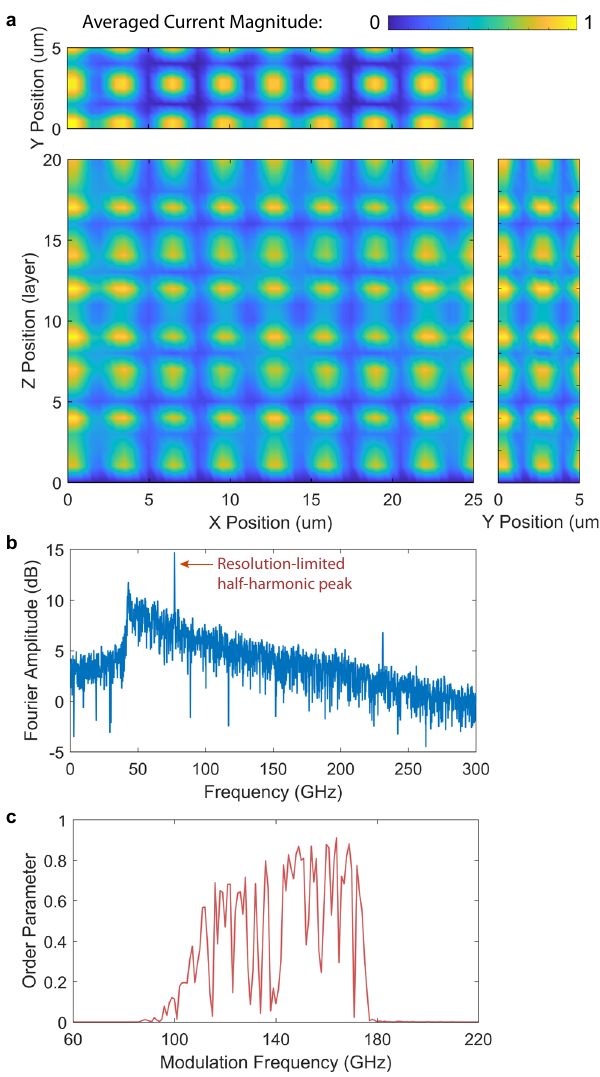
Fig. 5 Calculation on a 3D multi-layer long and wide Josephson junction stack in BSCCO under periodic laser illumination. The junction length is L = 25 μ m, width is W = 5 μ m, and layer number is N = 20. a An example ð x ; y ; z ; t Þi = j c2 in the Floquet steady state of expected spatial pro fi les of h j 2 z after being averaged over ( z , t ), ( x , t ), and ( y , t ) and plotted in the xy , yz, and Fig. 6 Comparison between the calculated temporal correlation function xz planes, respectively. The modulation frequency is f mod ¼ 154 GHz, the for 0D and 1D Josephson junctions in BSCCO. The time difference δ t takes laser power is P = 0.5 mW, and the bath temperature is T b = 4 K. b ¼ 1 = f up to 32768 cycles of modulation period T and the modulation Expected Fourier spectrum of j z ( x , y , z , t ) on the edge of the sample (0, 0, 0) mod mod amplitude is A mod ¼ 0 : 1. a 0D case with f mod ¼ 85 GHz. The insets show where it can convert to electromagnetic radiation and be detected. The slightly decayed oscillation amplitudes for the fi rst and last 10 modulation periods. b 1D case (evaluated at a speci fi c point with the space difference 77 GHz. c Expected parametric excitation band for the spatiotemporal order δ x = 0) with f ¼ 140 GHz. The insets show nearly the same oscillation parameter for various modulation frequencies f mod at the fi xed laser power mod amplitudes for the fi rst and last 10 modulation 0.5 mW. This spectrum is further broadened (compared with the 2D case).